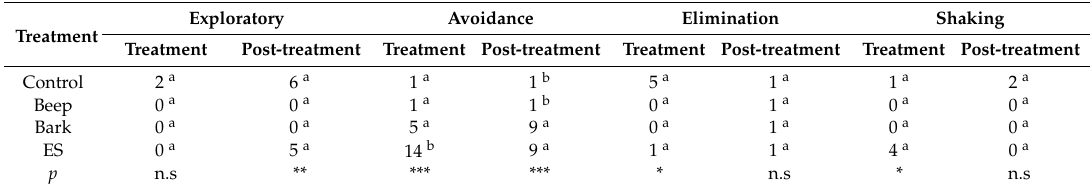
Table 4. Counts of point behaviors displayed during treatment and post-treatment observation periods for Control, Beep, Bark, and Electrical Stimulus treatments